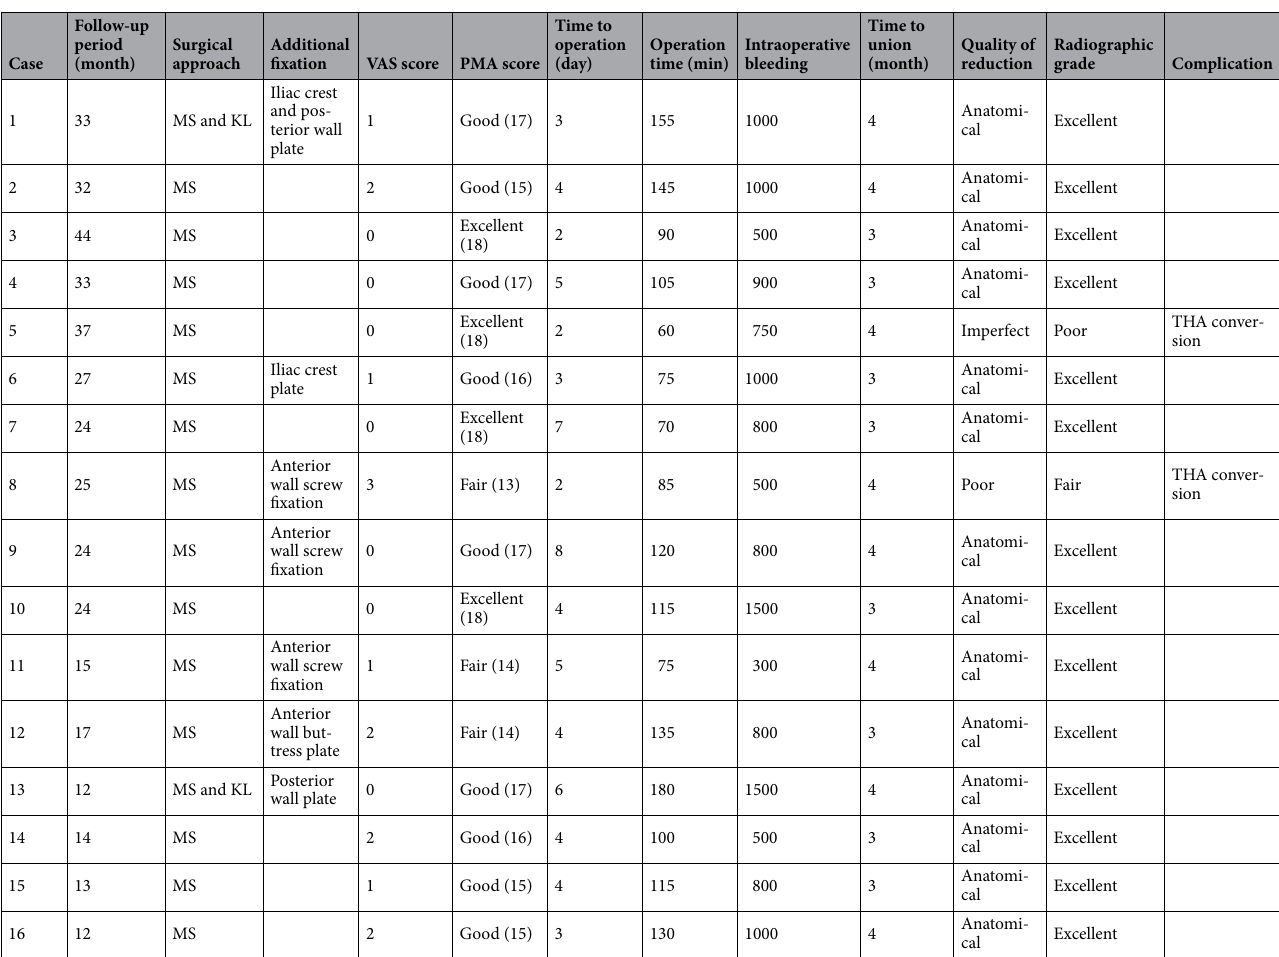
Table 3. Surgical outcomes of 16 patients using a quadrilateral surface plate through modified Stoppa approach. M-S Modified Stoppa, K-L Kocher-Langenbeck, VAS visual analogue scale, PMA Postel Merle d’Aubigné, THA total hip